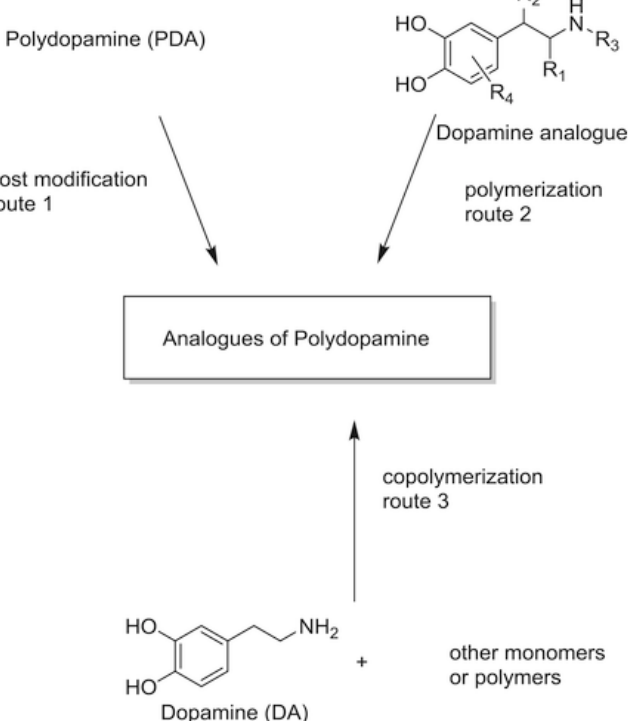
Figure 4. Polydopamine polymerization from different analogs [62]. Melanoidins